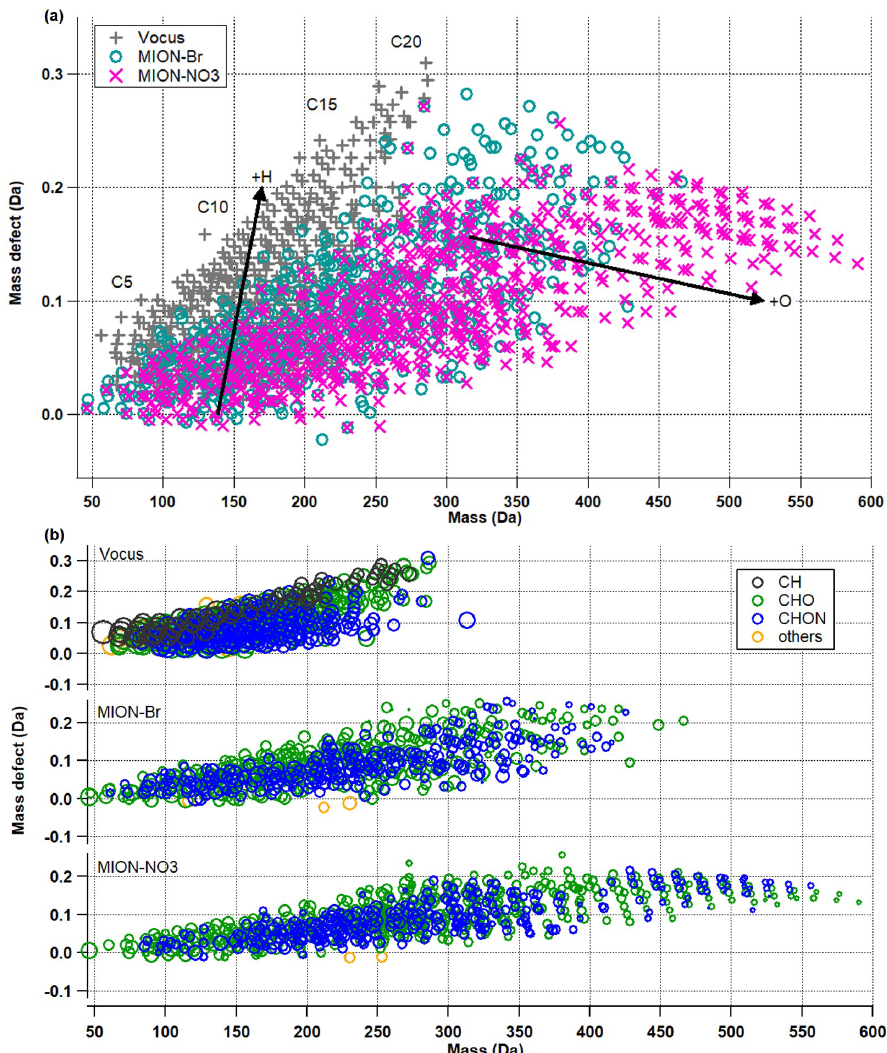
Figure 2. (a) Mass defect plots for organic compounds measured by Vocus, MION-Br, and MION-NO 3 ; (b) mass defect plots for organic compounds (separated into CH, CHO, CHON, and others) measured by Vocus, MION-Br, and MION-NO 3 . Markers in panel (b) were all sized by the logarithm of their corresponding